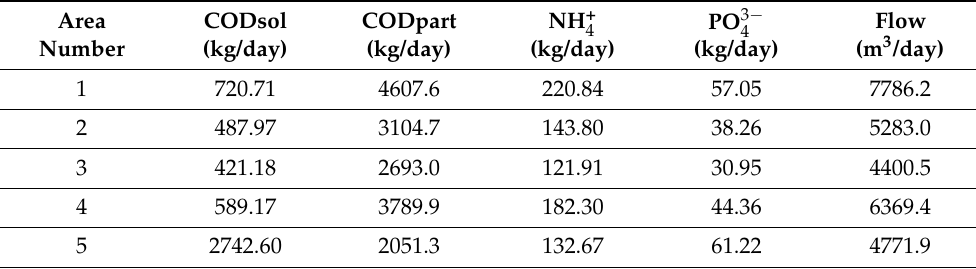
Table 3. Influent medium loads and flow